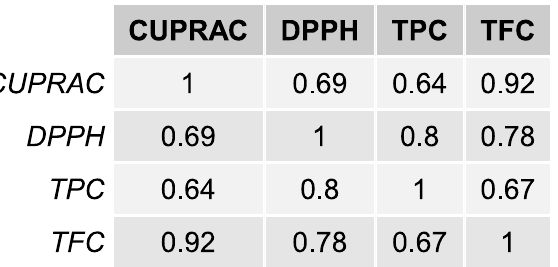
Figure 1. Correlations between the DPPH, CUPRAC, TPC, and TFC